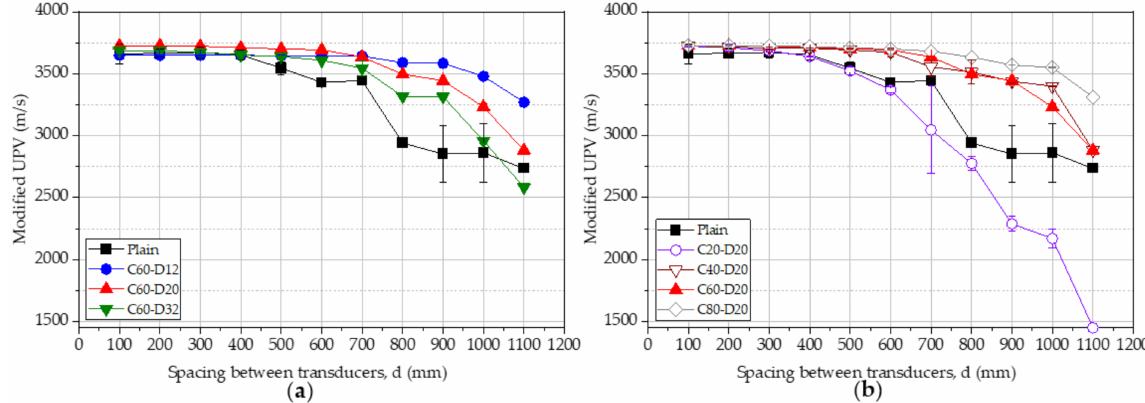
Figure 9. Modified UPV of beams, ( a ) varying bar diameter, ( b ) varying cover